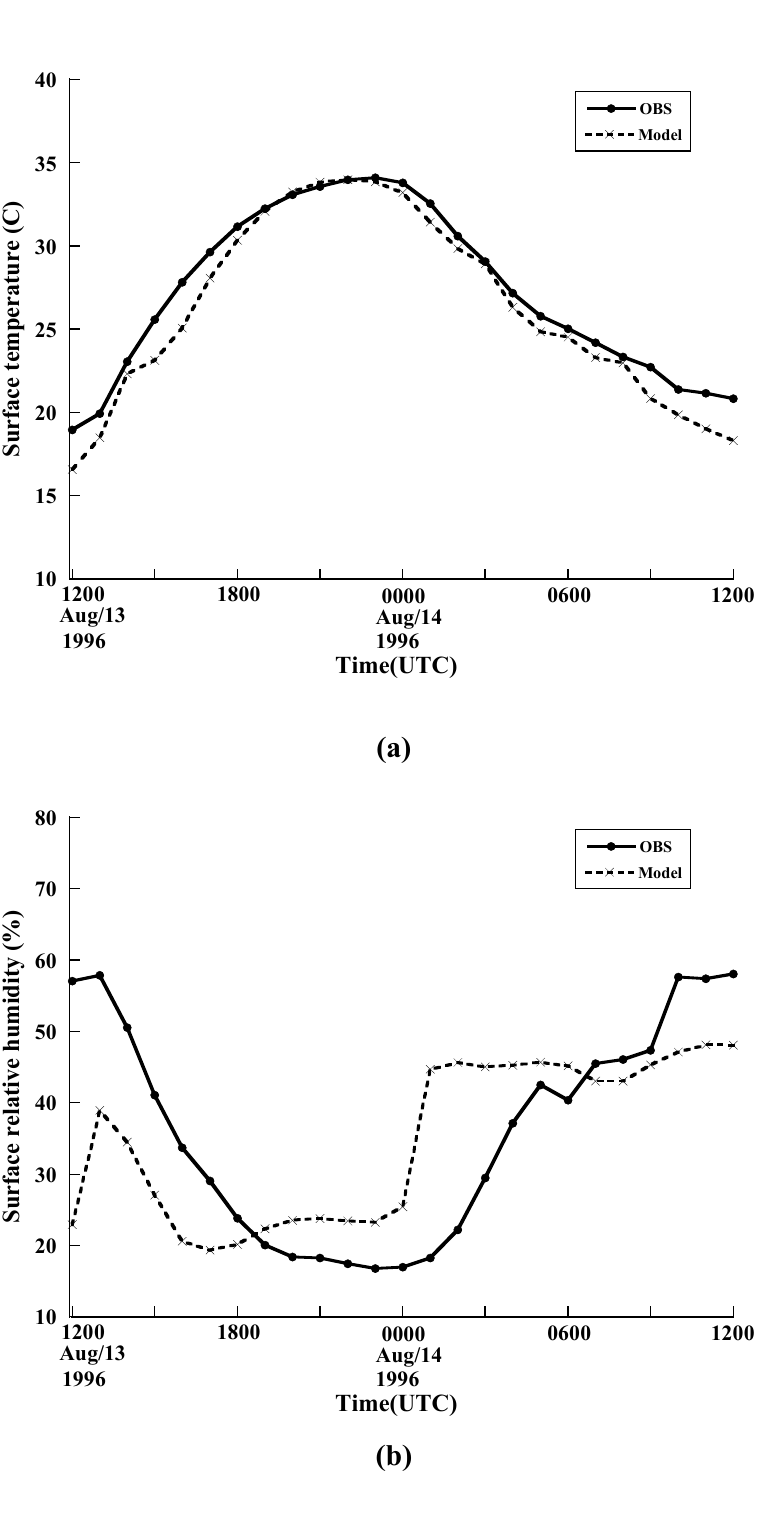
Figure 2. The time series comparison of hourly observed and predicted domain-averaged surface (a) temperature, (b) relative humidity, (c) wind speed, and (d) wind direction during the period from 1200Z 13 August to 1200Z 14 August 1996. The average is performed in fine domain (1km